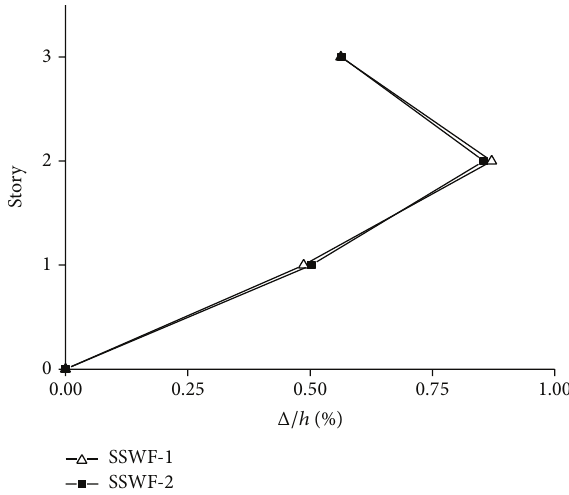
Figure 23: Interstory angles of structures under rare earthquake